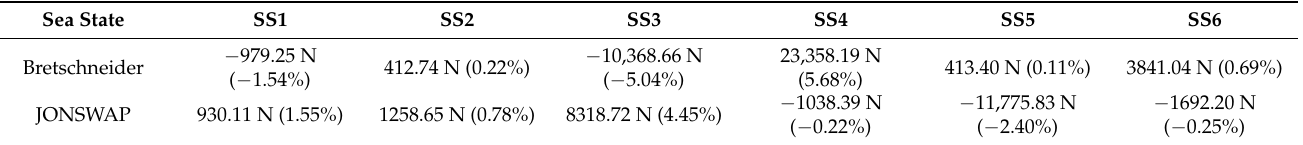
Figure 15. The comparison of the results obtained by ANN and BIEM for KCS for the Bretschneider ( left ) and JONSWAP ( right ) wave energy spectra after the data classification. Table 7. The absolute and percentage differences between the results obtained by ANN and BIEM for KCS after the data